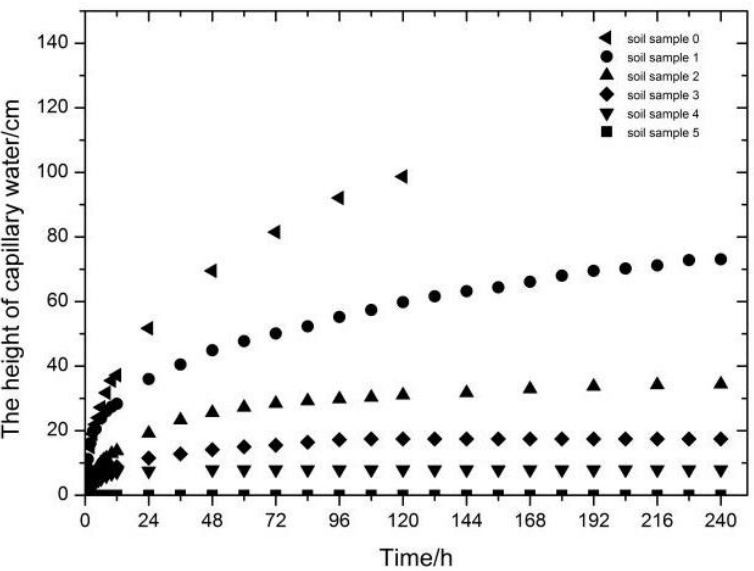
Figure 1. The relationship of the rise height of capillary water with time.